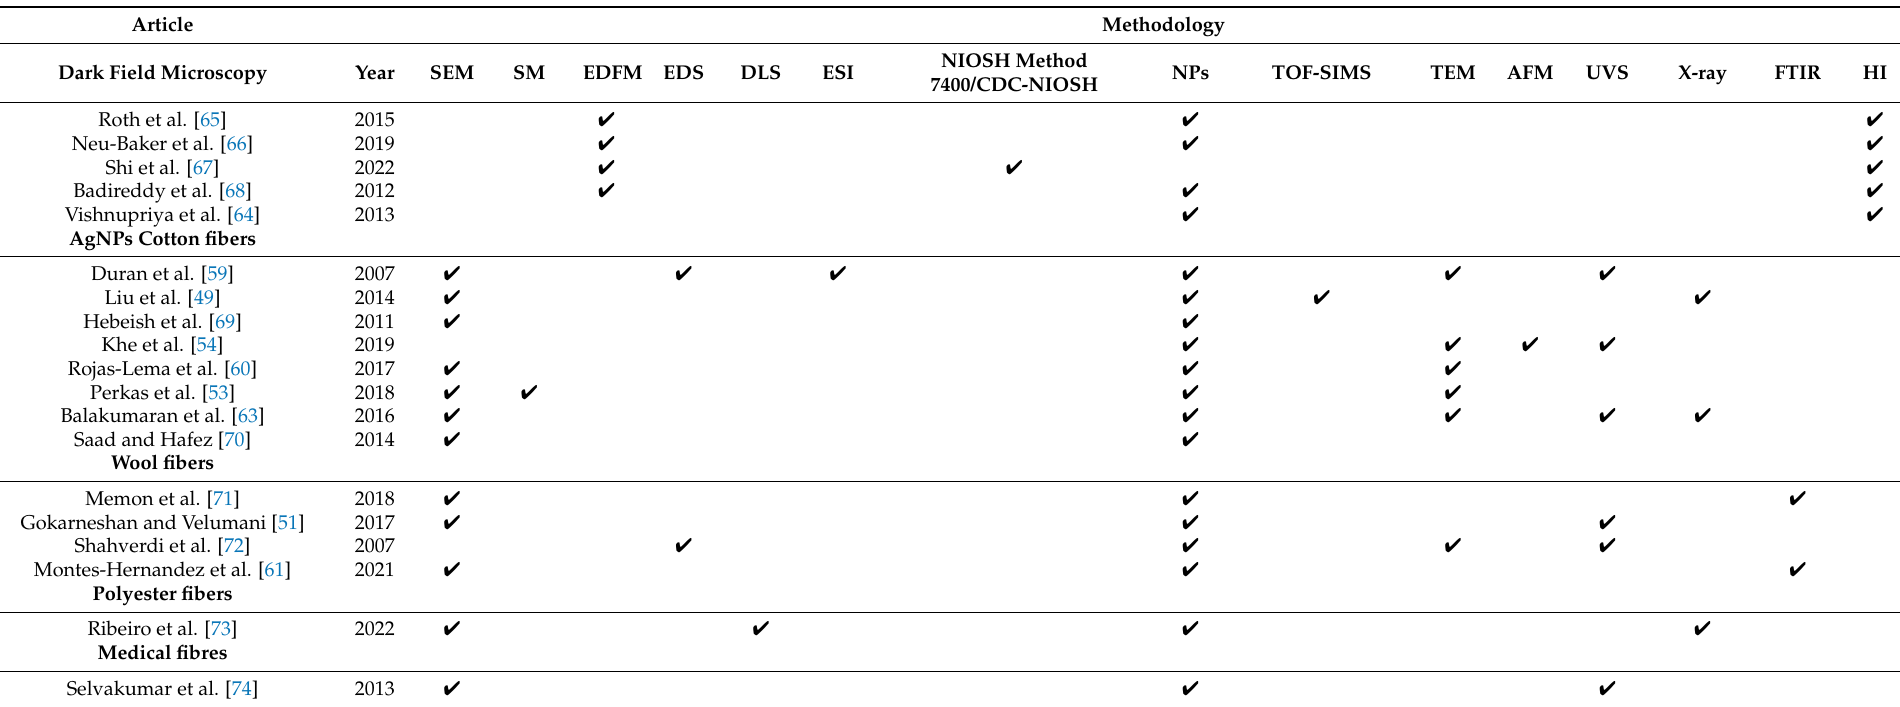
Table 1. The working methodology used in the reference bibliography for nanoparticle impregnation and material